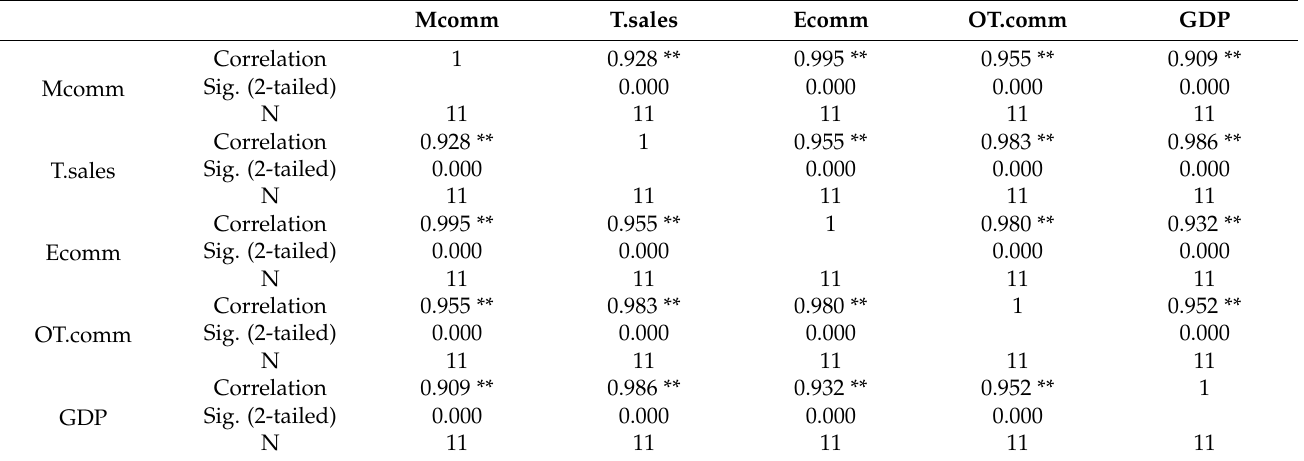
Table 2. Correlations between the variables that characterize sales and economic